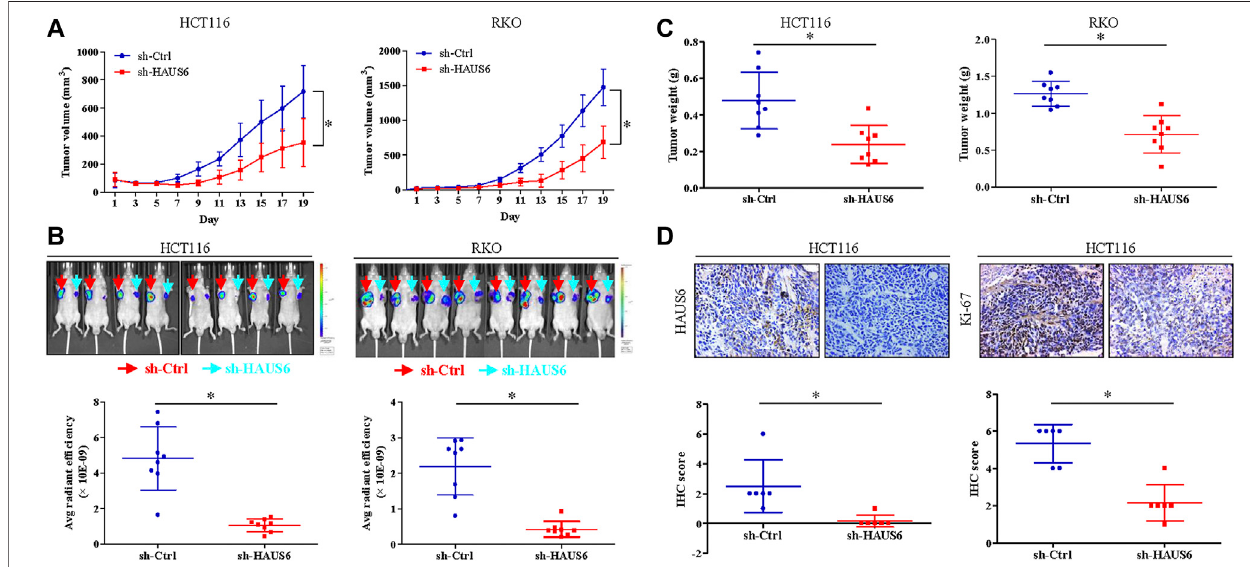
FIGURE 4 | HAUS6 knockdown reduces tumor growth and cell proliferation in vivo. (A) Tumor volume in BALB/c nude mice injected with HCT116 (left panel) or RKO (right panel) cells transduced with shRNA against HAUS6 or control shRNA. Mean ± SD; n (cid:1) 8; * p < 0.05, vs. sh-Ctrl, by independent Student ’ s t test. (B) GFP fl uorescence in BALB/c nude mice injected with HCT116 (left panel) or RKO (right panel) cells transduced with a GFP reporter and shRNA against HAUS6 or control shRNA. Representative fl uorescence images are shown above, and quantitation of GFP intensity is shown below. Mean ± SD; n (cid:1) 8; * p < 0.05, vs. sh-Ctrl, by independentStudent ’ s t test. (C) TumorweightinBALB/c nudemiceinjected withHCT116(left panel) orRKO(rightpanel) cellstransducedwithshRNAagainst HAUS6 orcontrolshRNAonday26afterinjection.Mean ± SD;n (cid:1) 8;* p < 0.05,vs.sh-Ctrl,byindependentStudent ’ s t test. (D) HAUS6andKi-67proteinlevelsinexcisedtumors fromBALB/cnudemiceinjectedwithHCT116cellstransducedwithshRNAagainstHAUS6orcontrolshRNA.Representativeimmunohistochemistryimagesareshown above. Magni fi cation: × 40; Mean ± SD; n (cid:1) 6; * p < 0.05, vs. sh-Ctrl, by independent Student ’ s t